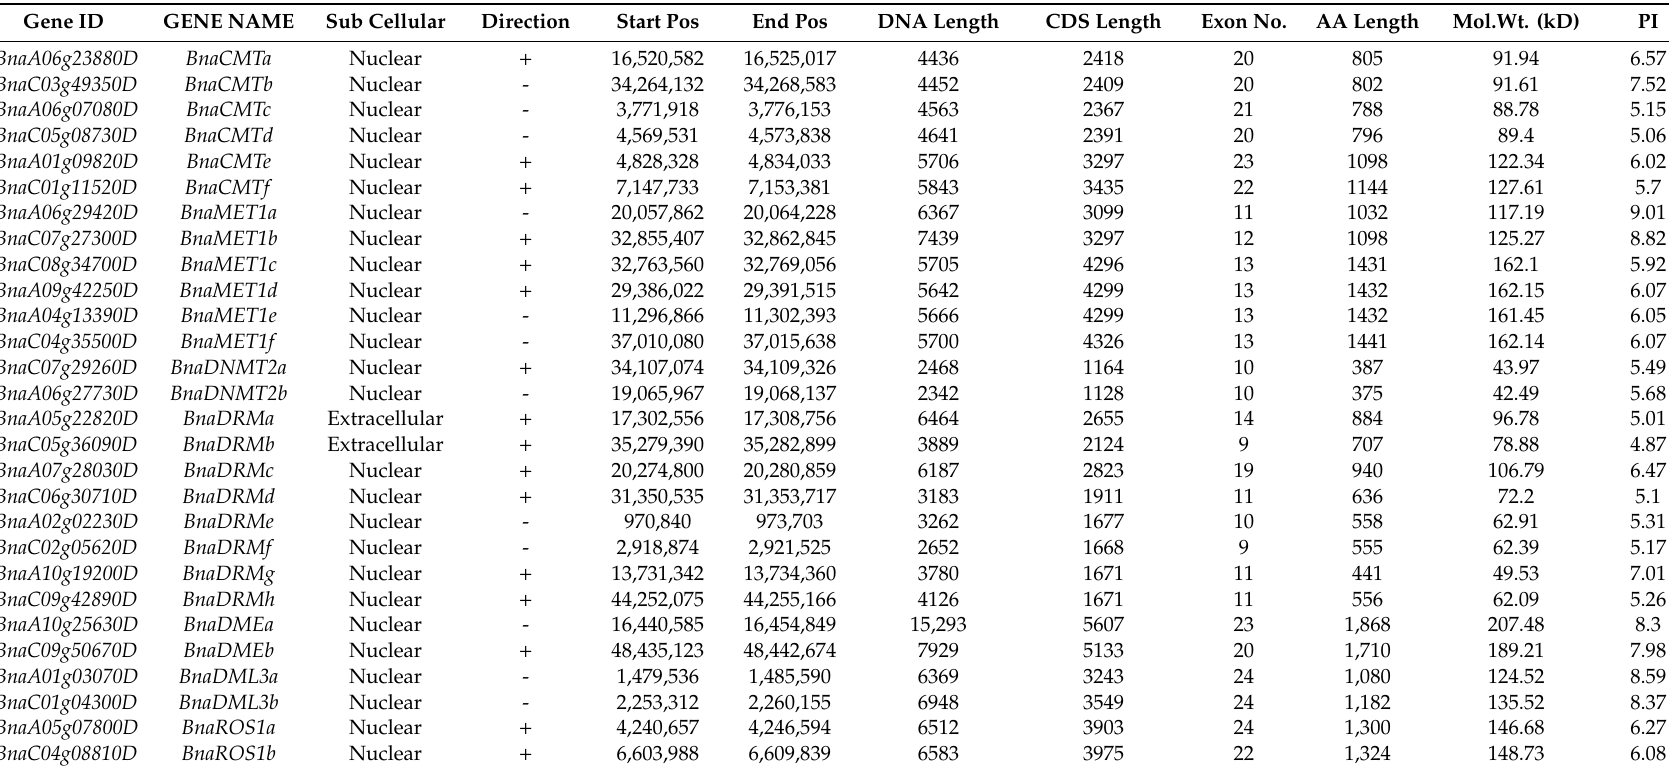
Table 1. Basic characteristic of genes encoding DNA methyltransferase (DNA-MTase) and DNA demethylase (DNA-deMTase) in